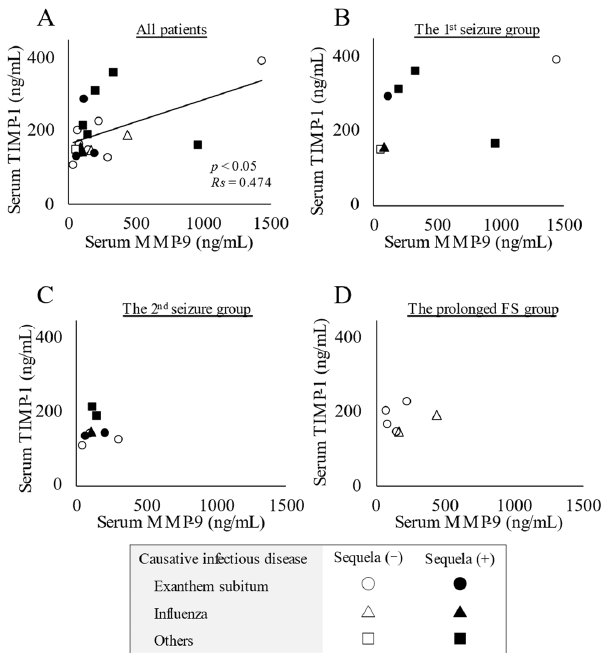
Figure 3. Relationship between serum concentrations of matrix metalloproteinase-9 (MMP-9) and tissue inhibitor matrix metalloproteinase-1 (TIMP-1). ( A ) Positive correlation between serum con- centrations of MMP-9 and TIMP-1 in all patients with acute encephalopathy with biphasic seizures and late reduced diffusion (AESD) or prolonged febrile seizure (FS). Statistical comparisons by Spearman’s correlation test. ( B ) The 1st seizure phase group. (C) The 2nd seizure phase group. ( D ) The prolonged FS group. Circles, triangles, and squares represent patients with AESD or FS due to exanthem subitum, influenza, and other infectious diseases, respectively. Filled marks donate patients with sequela (e), and open marks without